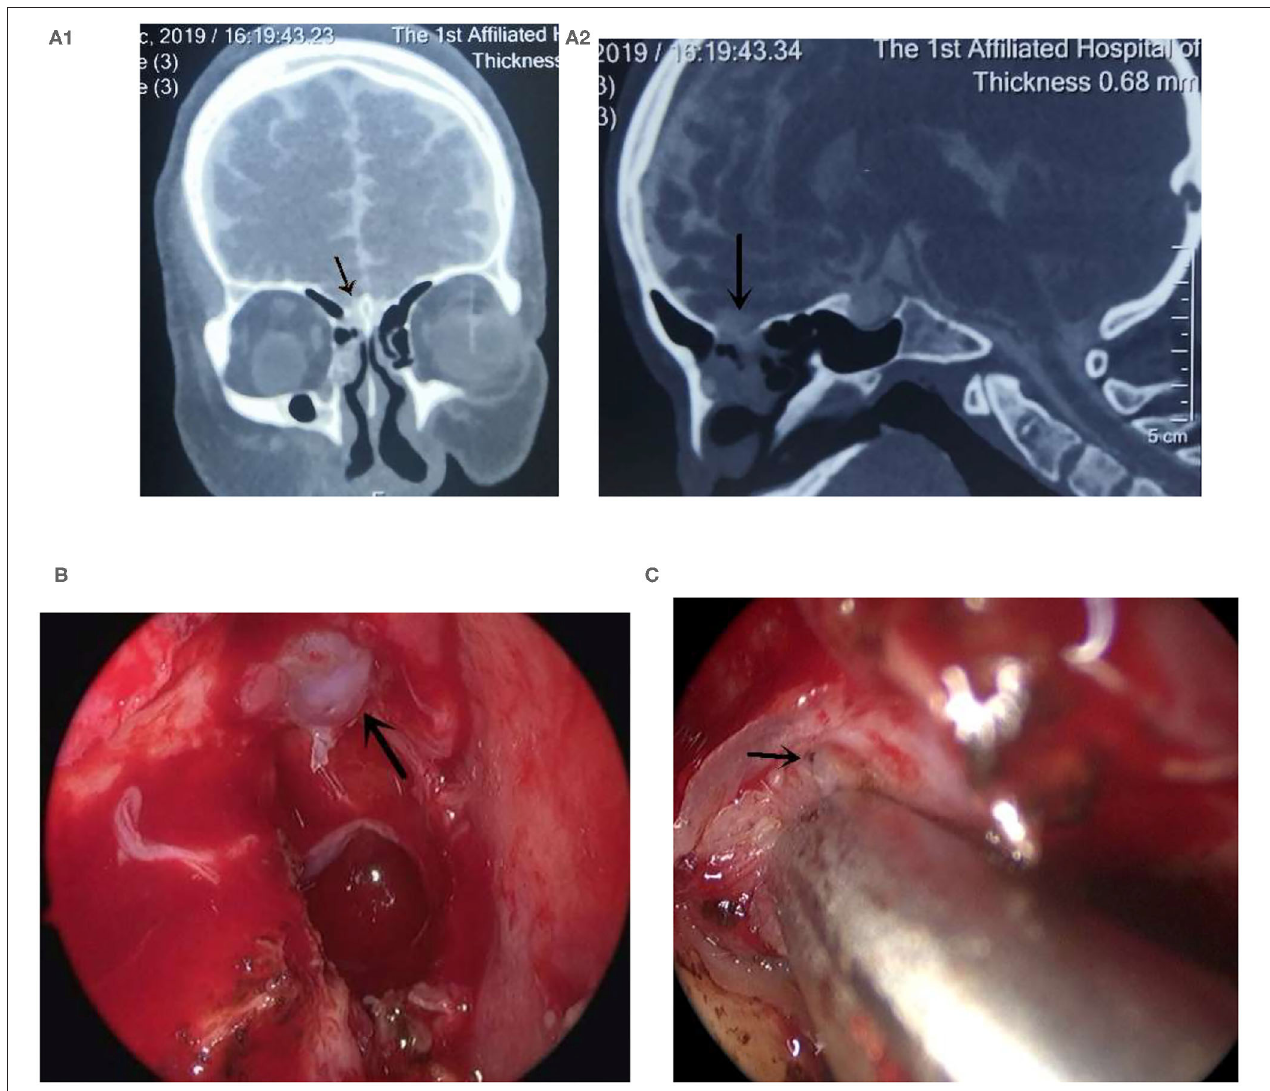
FIGURE 2 | The high-flow leak was repaired endoscopically. (A) The CTC examination showed that the leak was located in the right ethmoid pate, (A1) the coronal CT, (A2) the sagittal CT, arrow showed the leak; (B) Arrow showed the edematous mucosa; (C) Exposed “pinpoint” leak after the injection of saline through lumbar drainage indicated by the